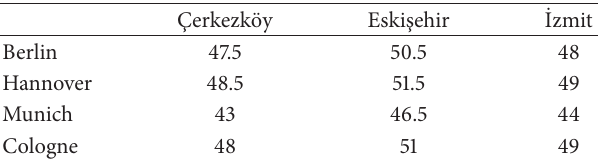
Table 2: Product based transportation times (TTr 1 𝑝𝑖𝑙𝑎 ) from man- ufacturing facilities in Germany to local warehouses in Turkey